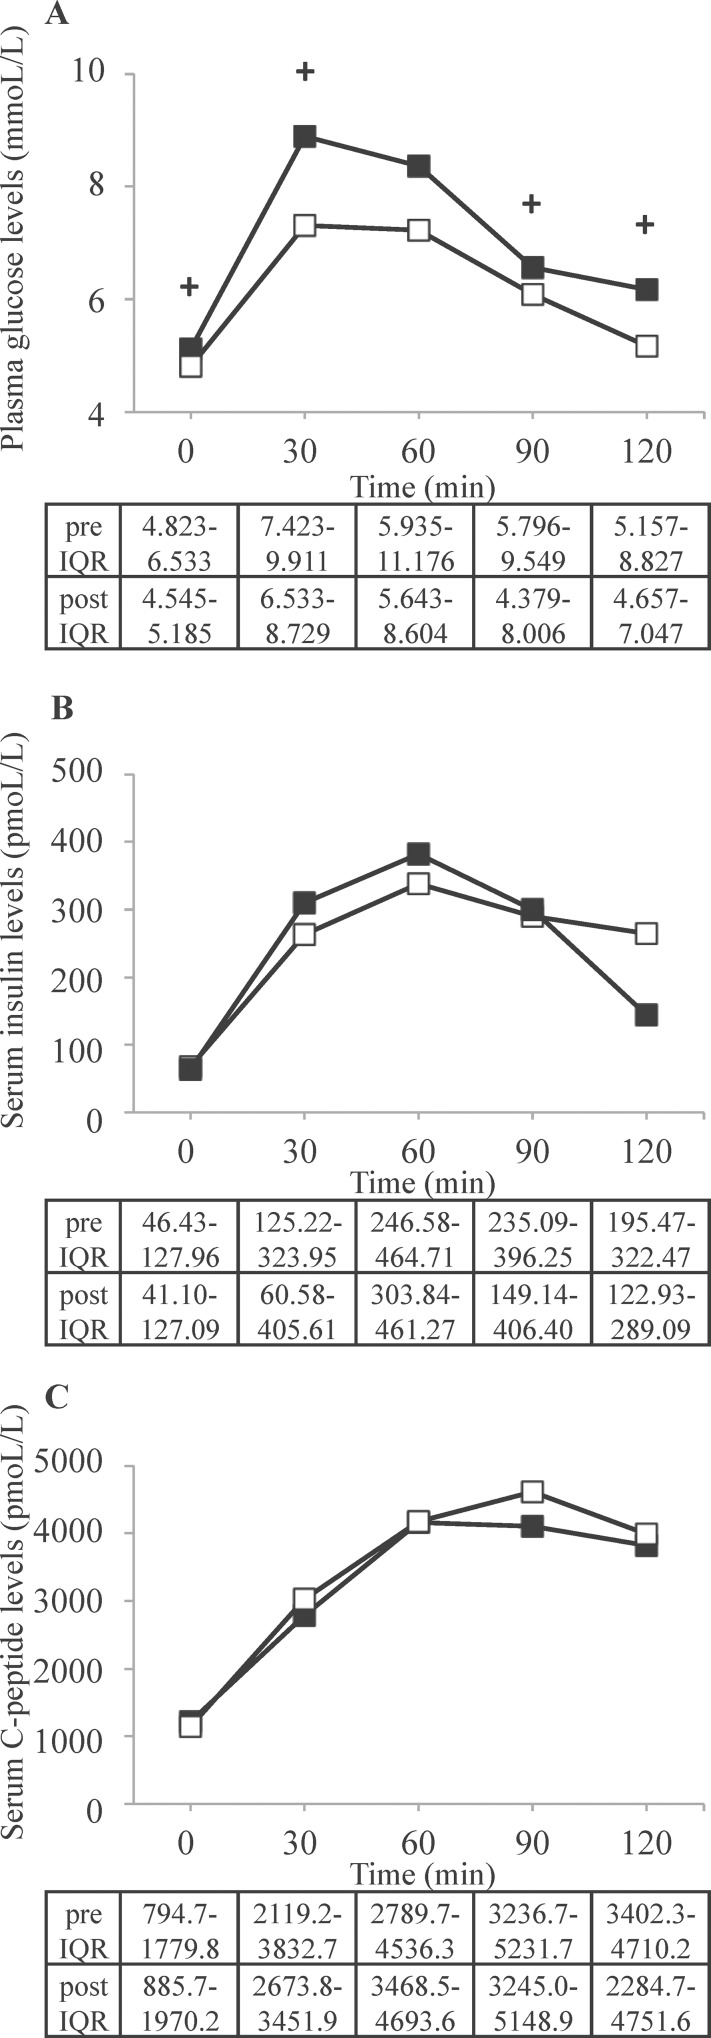
Metabolic parameters before and three months after conversion.Determination of plasma glucose (A), serum insulin (B) and C-peptide (C) levels by OGTTs performed prior to (full symbols) and three months after (blank symbols) the conversion from taxrolimus to cyclosporine A. Data are expressed as median (IQR). + indicates p <0.05 (in detail for plasma glucose levels: p = 0.012 at 0min, p = 0.025 at 30 min, p = 0.059 at 60 min, p = 0.022 at 90 min, p = 0.028 at 120 min).